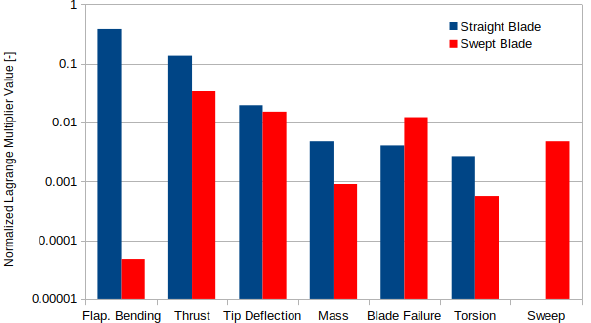
Figure 7. Lagrange multipliers associated with load